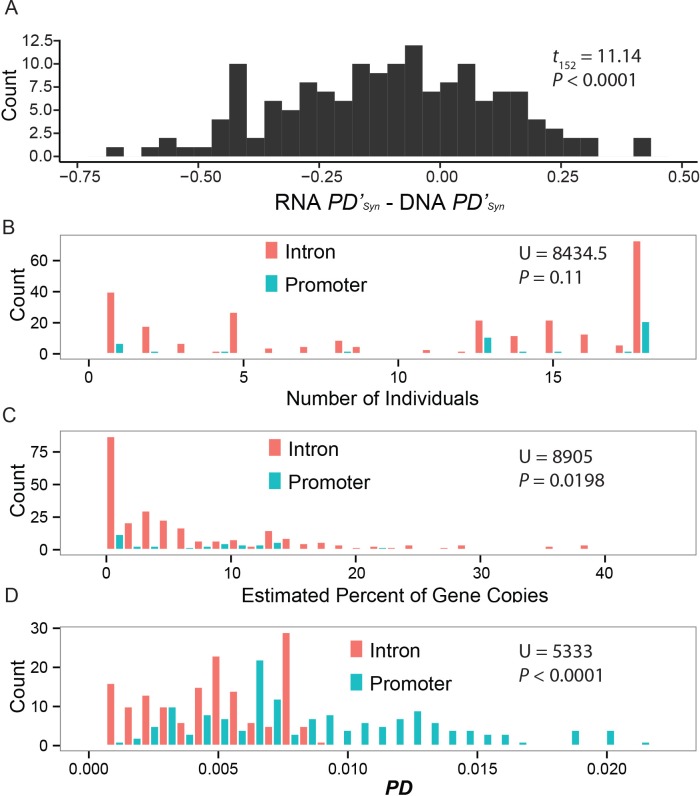
Selection on promoter sequences.(A) Variable gene transcription leads to a decrease in synonymous diversity in RNA compared to DNA, though the opposite pattern is found for non-synonymous sites. If variable gene expression were the result of a neutral process, it would be expected to influence patterns of diversity at non-synonymous and synonymous sites similarly. The increase in non-synonymous site individuality and simultaneous decrease in synonymous site individuality in RNA compared to DNA points to selection acting to increase individuality. Elevated sequence variation in promoter regions immediately upstream of the start codon provides additional evidence for frequency-dependent selection acting on regulatory sequences increasing individuality in urinary signals. (B) Compared to intronic variants, promoter sequence variants occur in similar numbers of individuals but (C) are found at more moderate frequencies. (D) Diversity measured as PD is much higher in the promoter region compared to introns.